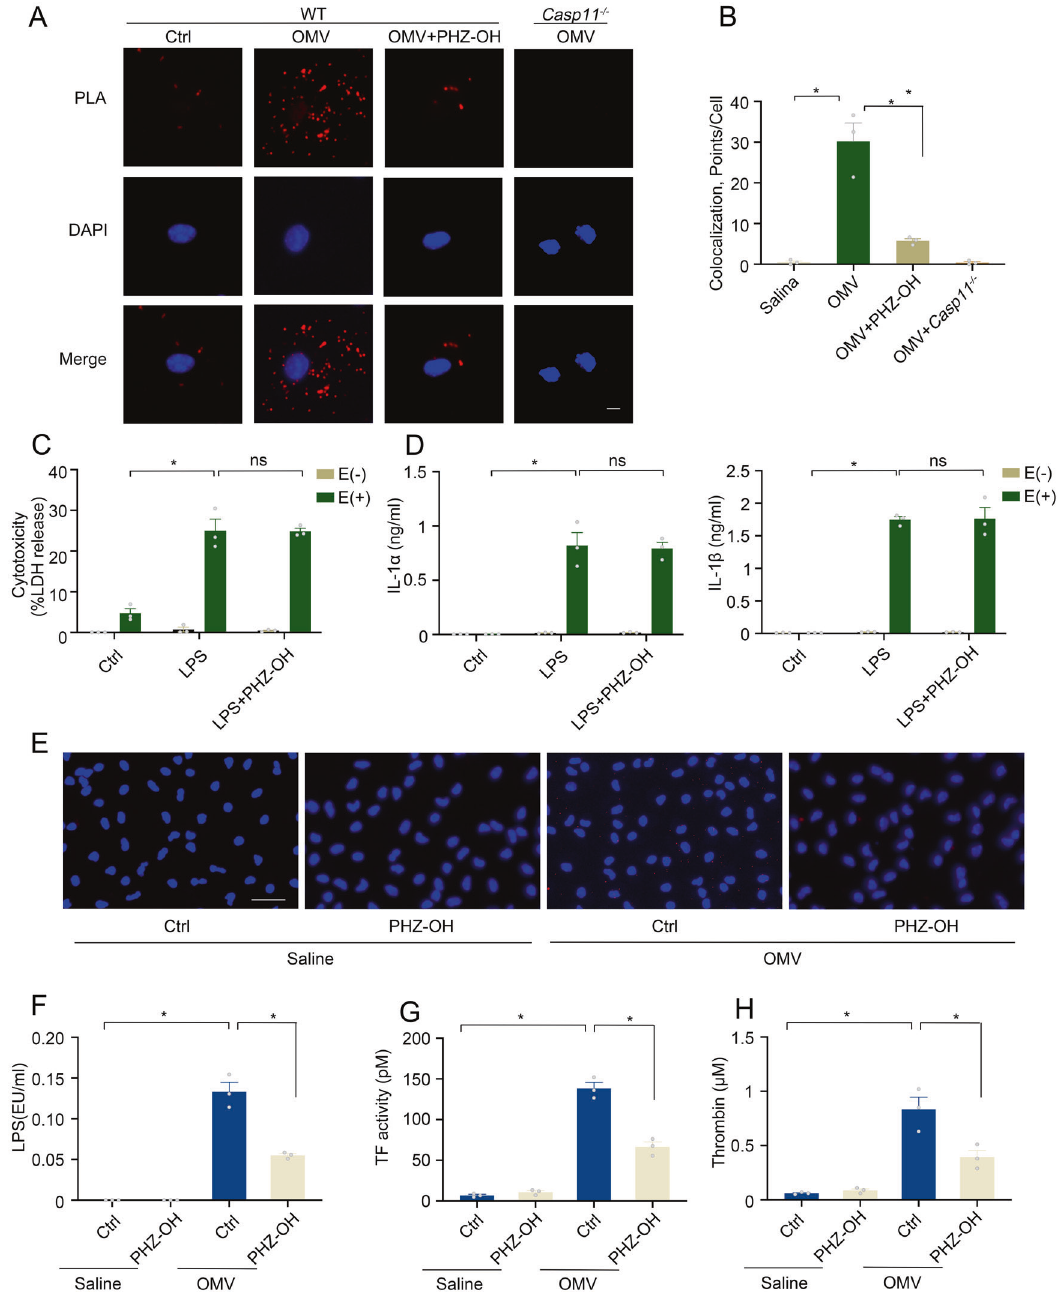
Fig. 6 PHZ-OH inhibits LPS internalization and caspase-11-mediated TF activity. A Images of Proximity Ligation Assay (PLA) showing the accessing of LPS and caspase-11 (Red, Scar bar = 10 μ m) within mouse peritoneal macrophages treated with saline or OMV (10 μ g/ml) for 2 h in the presence or absence of PHZ-OH (4 μ M); B Quantitative results of PLA. A spot means the average red points per cell in fi ve random views of the indicated group within a slide; Cytotoxicity ( C ) and IL-1 α / β release ( D ) of mouse peritoneal macrophages under a treatment of saline or PHZ-OH (4 μ M) and/or a challenge of LPS (1 μ g/ml) for 16 h with (E + ) or without (E − ) electroporation; Fluorescent staining of LPS (Red) ( E ) and LPS level of the cytosolic fraction assessed by using LAL assay (EU, endotoxin units) ( F ) in mouse peritoneal macrophages treated with saline or OMV (10 μ g/mL) for 2 h in the presence or absence of PHZ-OH (4 μ M); TF activity ( G ) and thrombin formation ( H ) of mouse peritoneal macrophages treated with saline or OMV (10 μ g/mL) for 16 h in the presence or absence of PHZ-OH (4 μ M). Data are shown as mean ± SEM of three independent experiments. * P < 0.05. ns, not signi fi